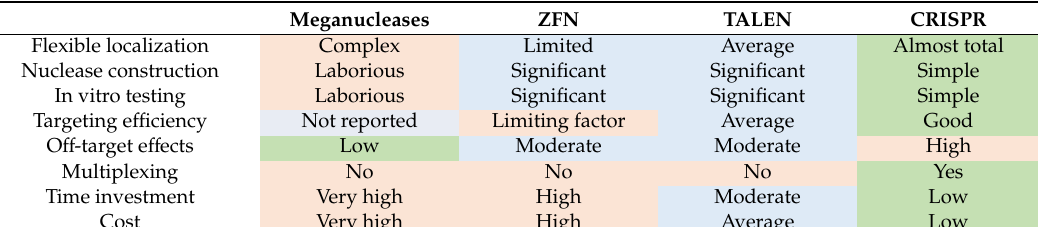
Table 1. Comparison of gene editing